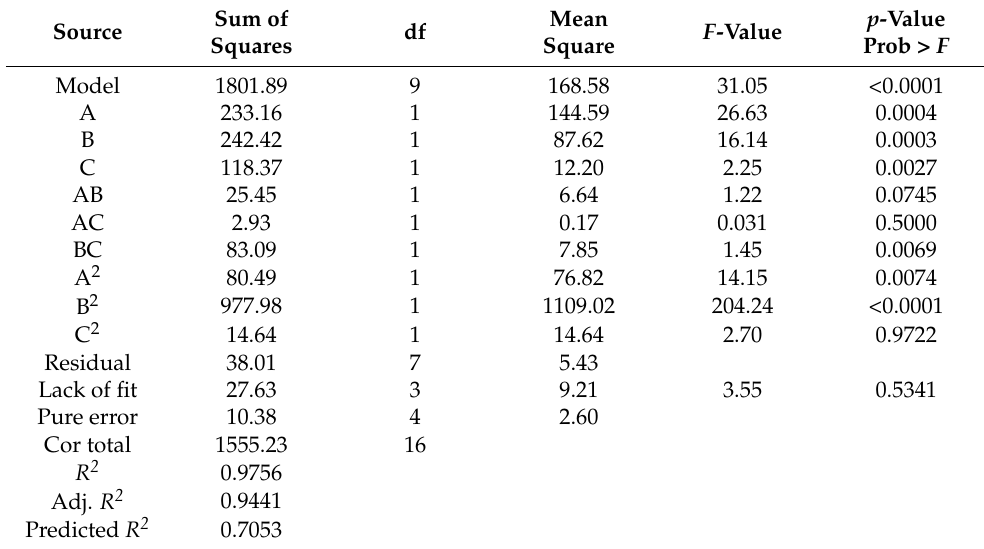
Table 5. Analysis of variance table for TRS yield as the response in enzymatic